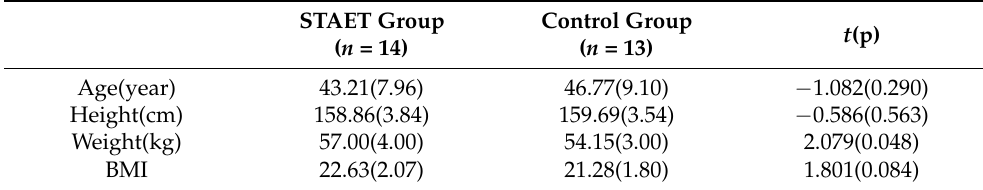
Table 3. Demographic data of groups (N =